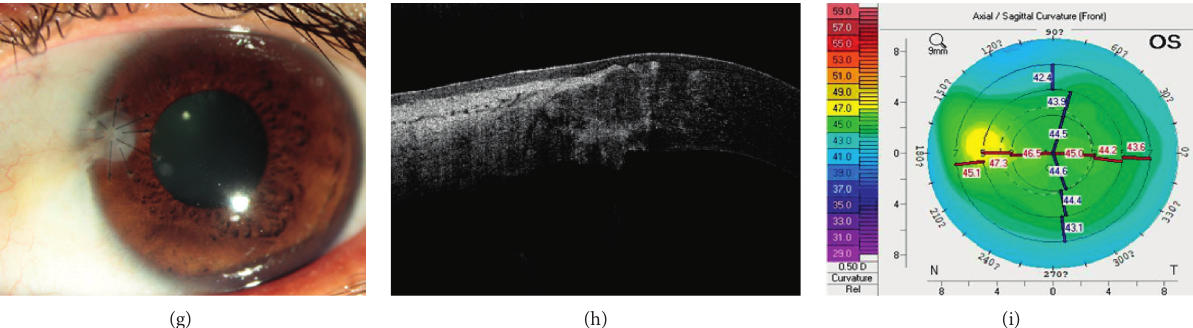
Figure 2: Penetrating corneal patching with a conical graft for corneal perforation. (a) Corneal perforation at 10 o’clock, with the UCVA being 0.22 logMAR. (b) AS-OCT indicates that the tissue defects’ diameter of the anterior and posterior surfaces is 1.88mm and 897 μ m, respectively. (c) A photograph at 1 week after surgery. (d–f) Examination at 12 months after surgery. (d) The graft opacity is slightly increased, and the UCVA is 0.15 logMAR. (e) AS-OCT displays the profile of the corneal patch, with the diameter in the anterior surface being 1.94mm and the posterior surface being 933 μ m. (f) The curvature of the front cornea is 44.7/45.7. (g–i) Examination at 24 months after surgery. (g) The graft opacity is increased, and the UCVA is 0.097 logMAR. (h) AS-OCTdisplays the profile of the corneal patch. (i) The curvature of the front cornea is